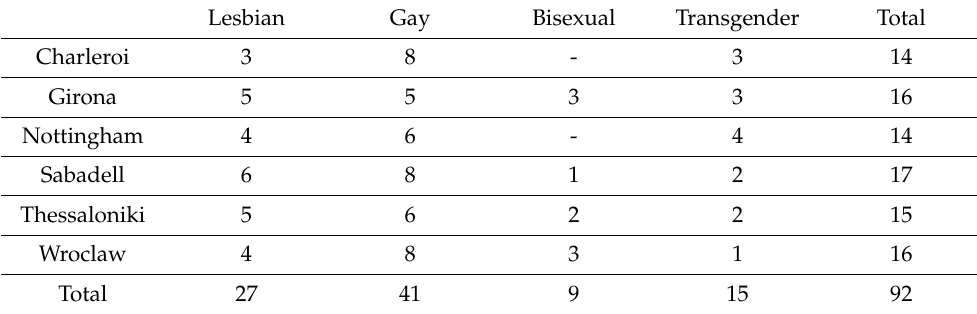
Table 1. Sexual orientation of participants for individual interviews.